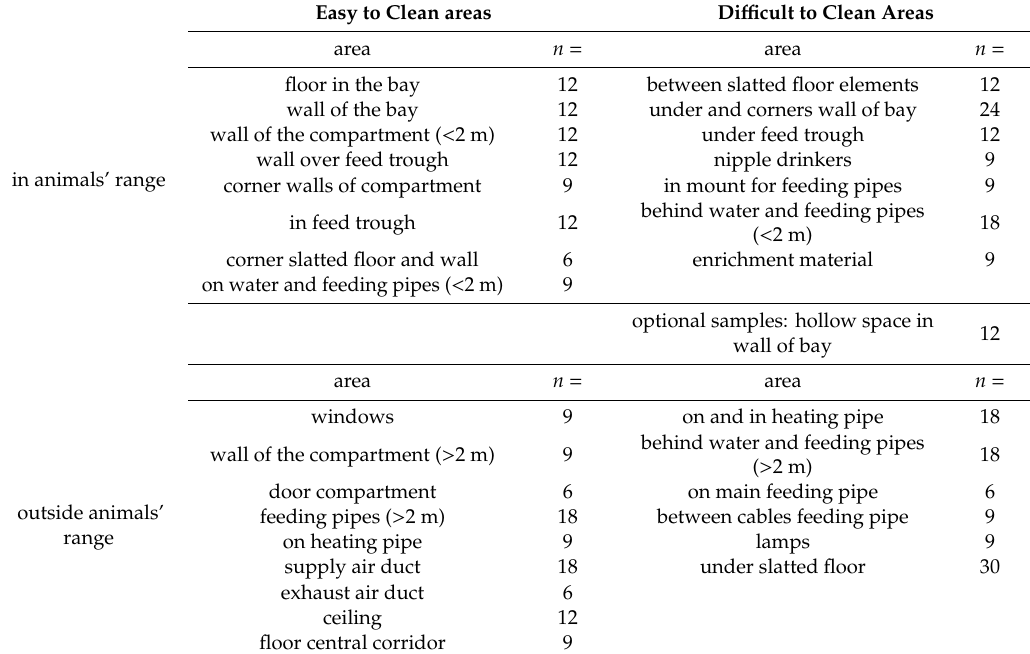
Table 2. Sampling